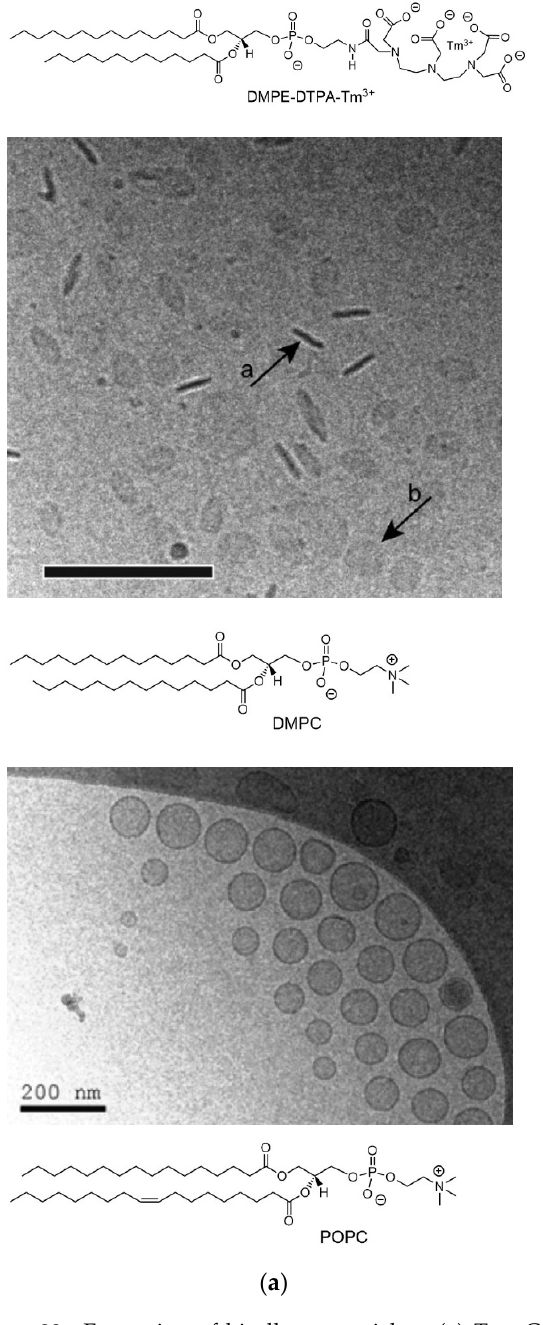
Figure 23. Formation of bicelles or vesicles. ( a ) Top : Cryo-TEM image of an aqueous dispersion of bicelles formed from an aqueous DPMC:DMPE-DTPA:Tm 3+ (4:1:1, molar ratio) mixture (total lipid concentration: 15 mM), prepared by polycarbonate membrane extrusion with final extrusion through 100 nm-sized pores, frozen from T = 5 °C (bar: 200 nm); see text. The two arrows point to a bicelle lying edge-on ( a ) and one lying face-on (b) [287]. Bottom: Cryo-TEM image of an aqueous dispersion of vesicles formed from an aqueous POPC:DMPE-DTPA:Tm 3+ (4:1:1, molar ratio) mixture, prepared by polycarbonate membrane extrusion with final extrusion through 100 nm-sized pores, frozen from T = 5 °C (bar: 200 nm) [289]. ( b ) Top: Schematic representation of a 4:1:1 DPMC:DMPE-DTPA:Tm 3+ bicelle, indicating the non-homogenous distribution of the two amphiphiles within the bicelle. Bottom: Temperature dependence of the aggregates formed in aqueous dispersions of DPMC:DMPE-DTPA:Tm 3+ (4:1:1, molar ratio), at a total lipid concentration of 15 mM [288]. DPMC:DMPE-DTPA:Tm 3+ is 1,2-dimyristoyl- sn -glycero-3-phosphoethanolamine-diethylenetriaminepentaacetate, complexed to a paramagnetic thulium ion (Tm 3+ ). Reproduced with permission from [287], American Chemical Society, 2010; from [289], American Chemical Society, 2010; and from [288], ETH Zürich, 2013.